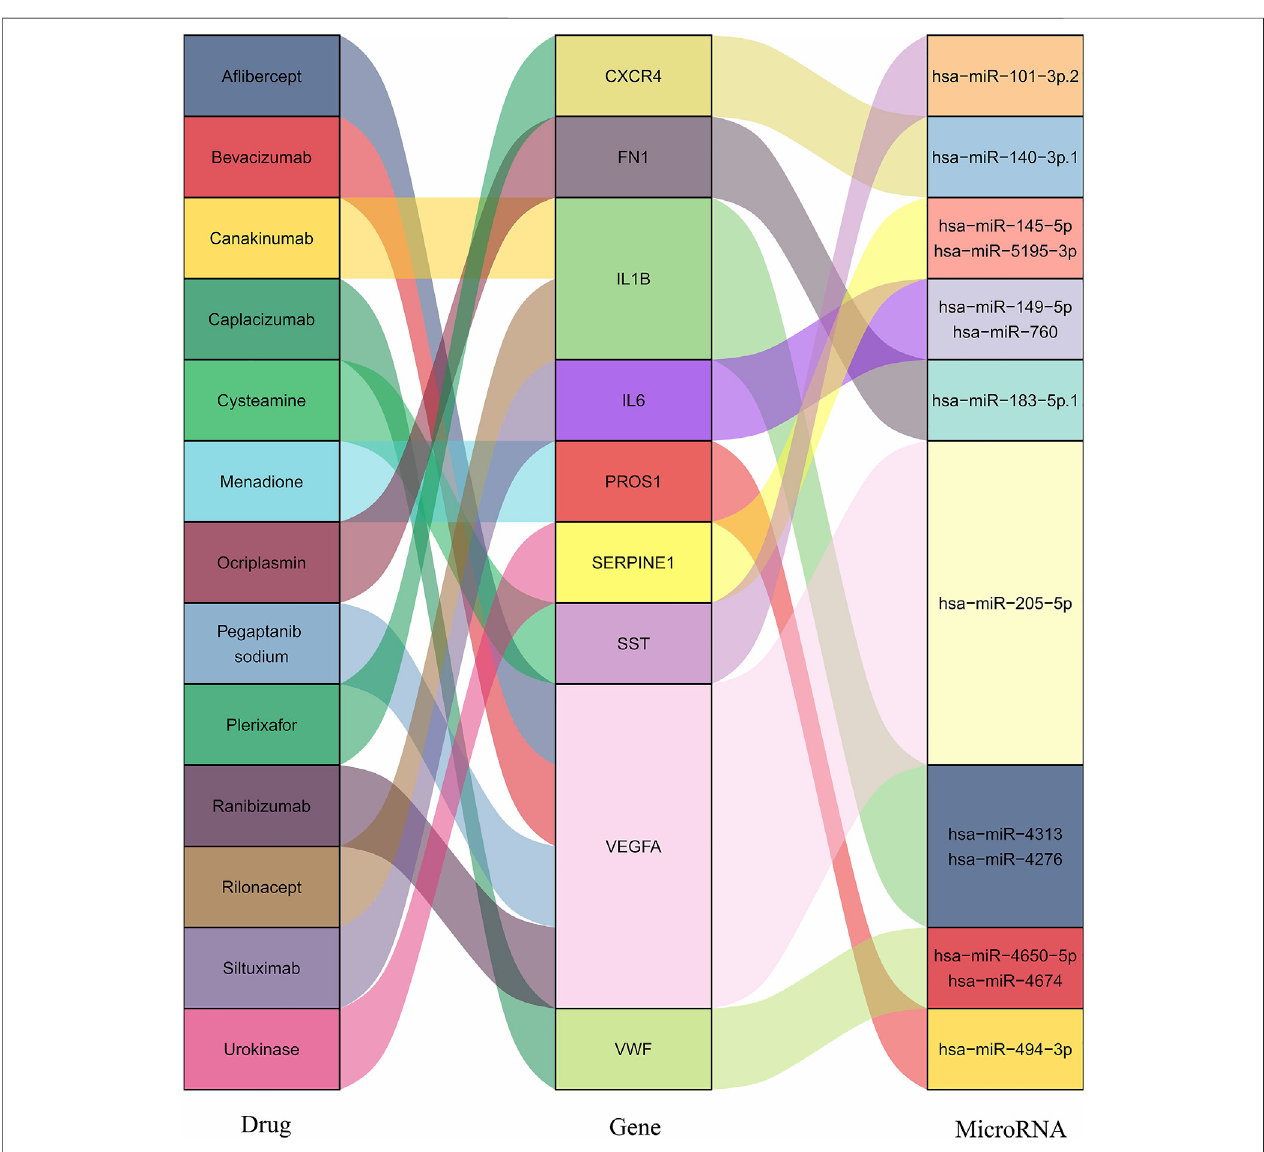
FIGURE 4 | The interactions of hub genes with drugs and MicroRNA. The interaction of nine hub genes with 13 drugs and MicroRNA.